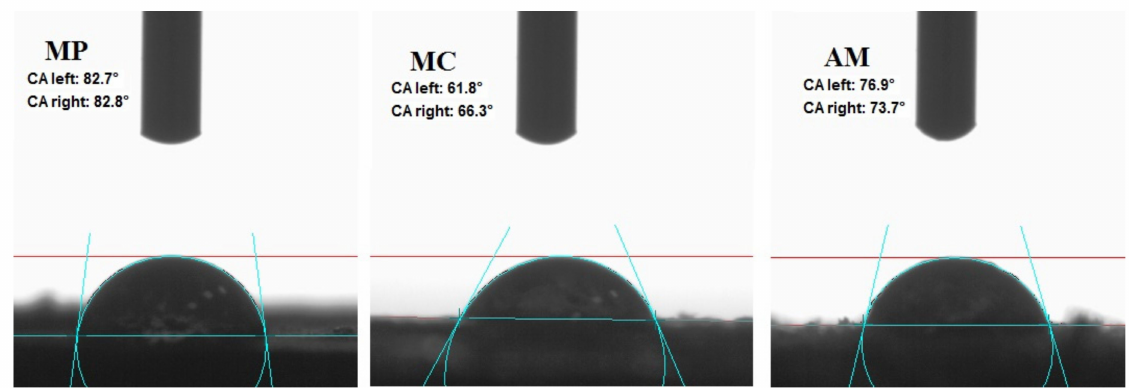
Figure 4. Contact angle (CA) measurements of peppermint (MP), German chamomile (MC) and yarrow